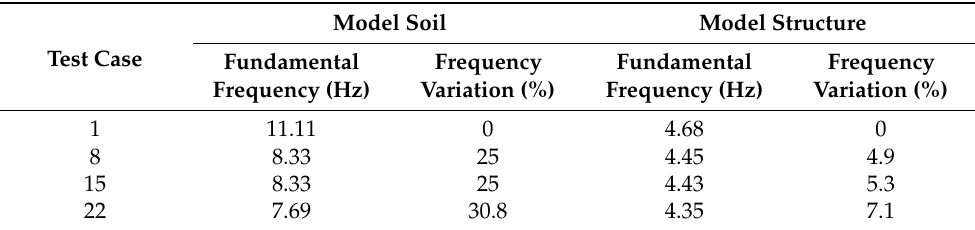
Table 3. First-order natural frequency of the model soil and model structure.